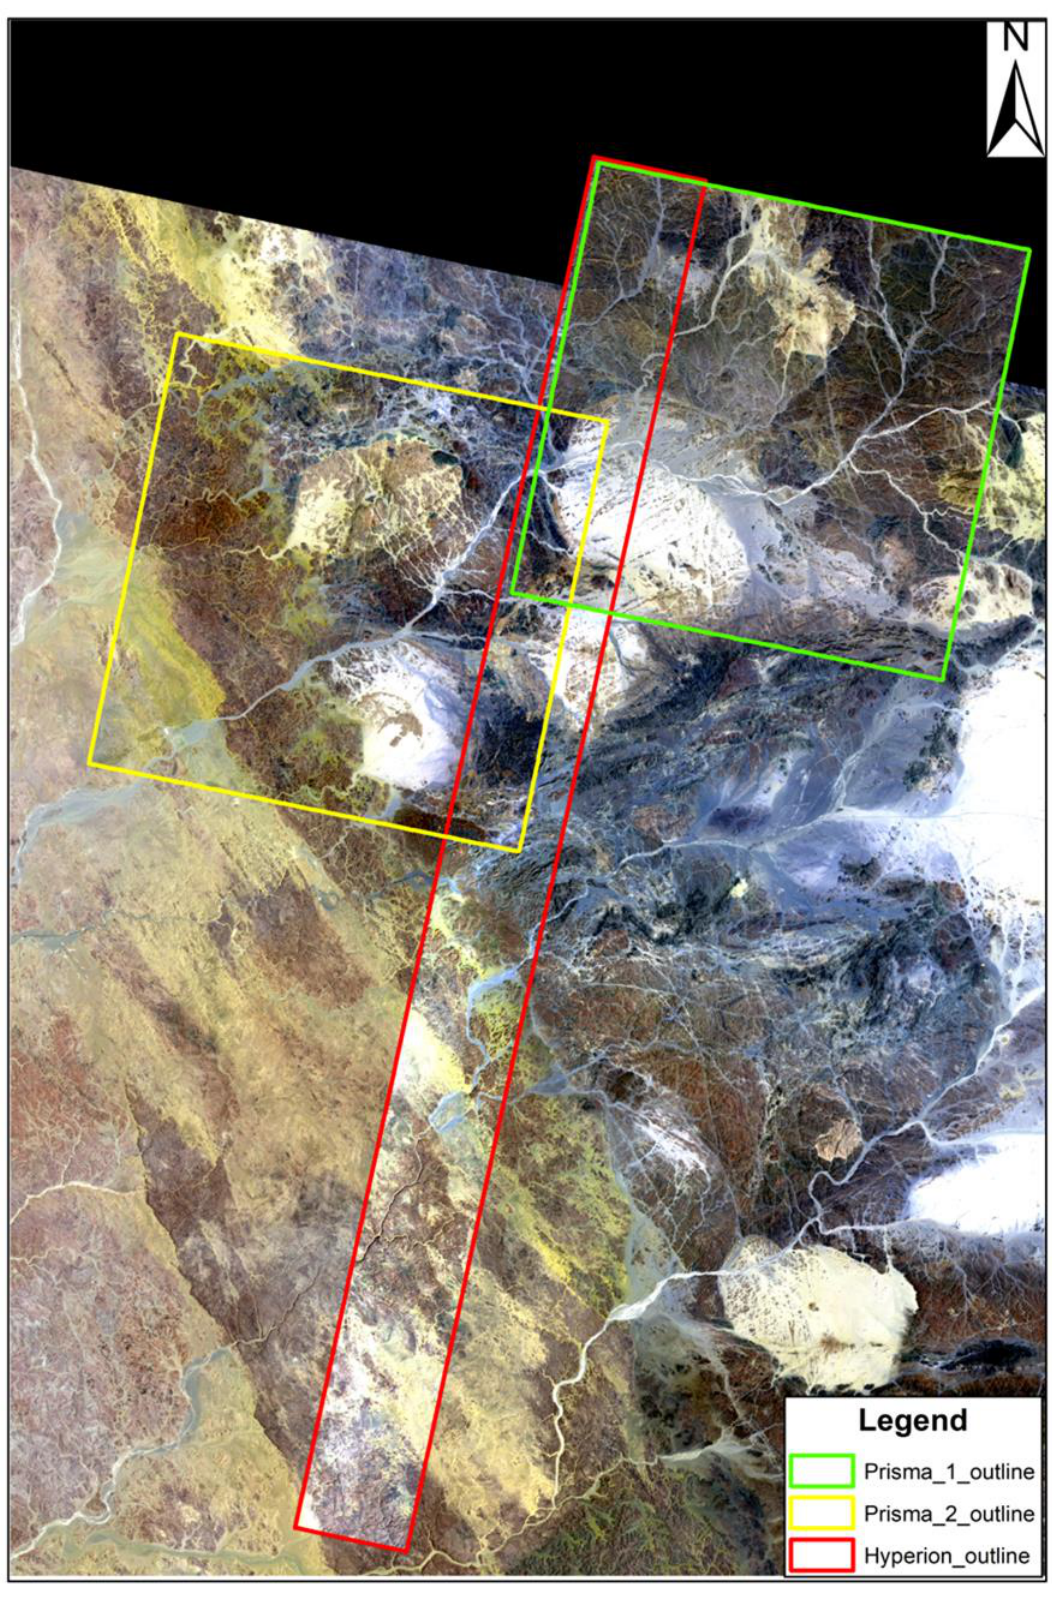
Figure 9. RGB composite of the original datasets of both Hyperion and Prisma bands superimposed on the predicted Hyperion bands (background).